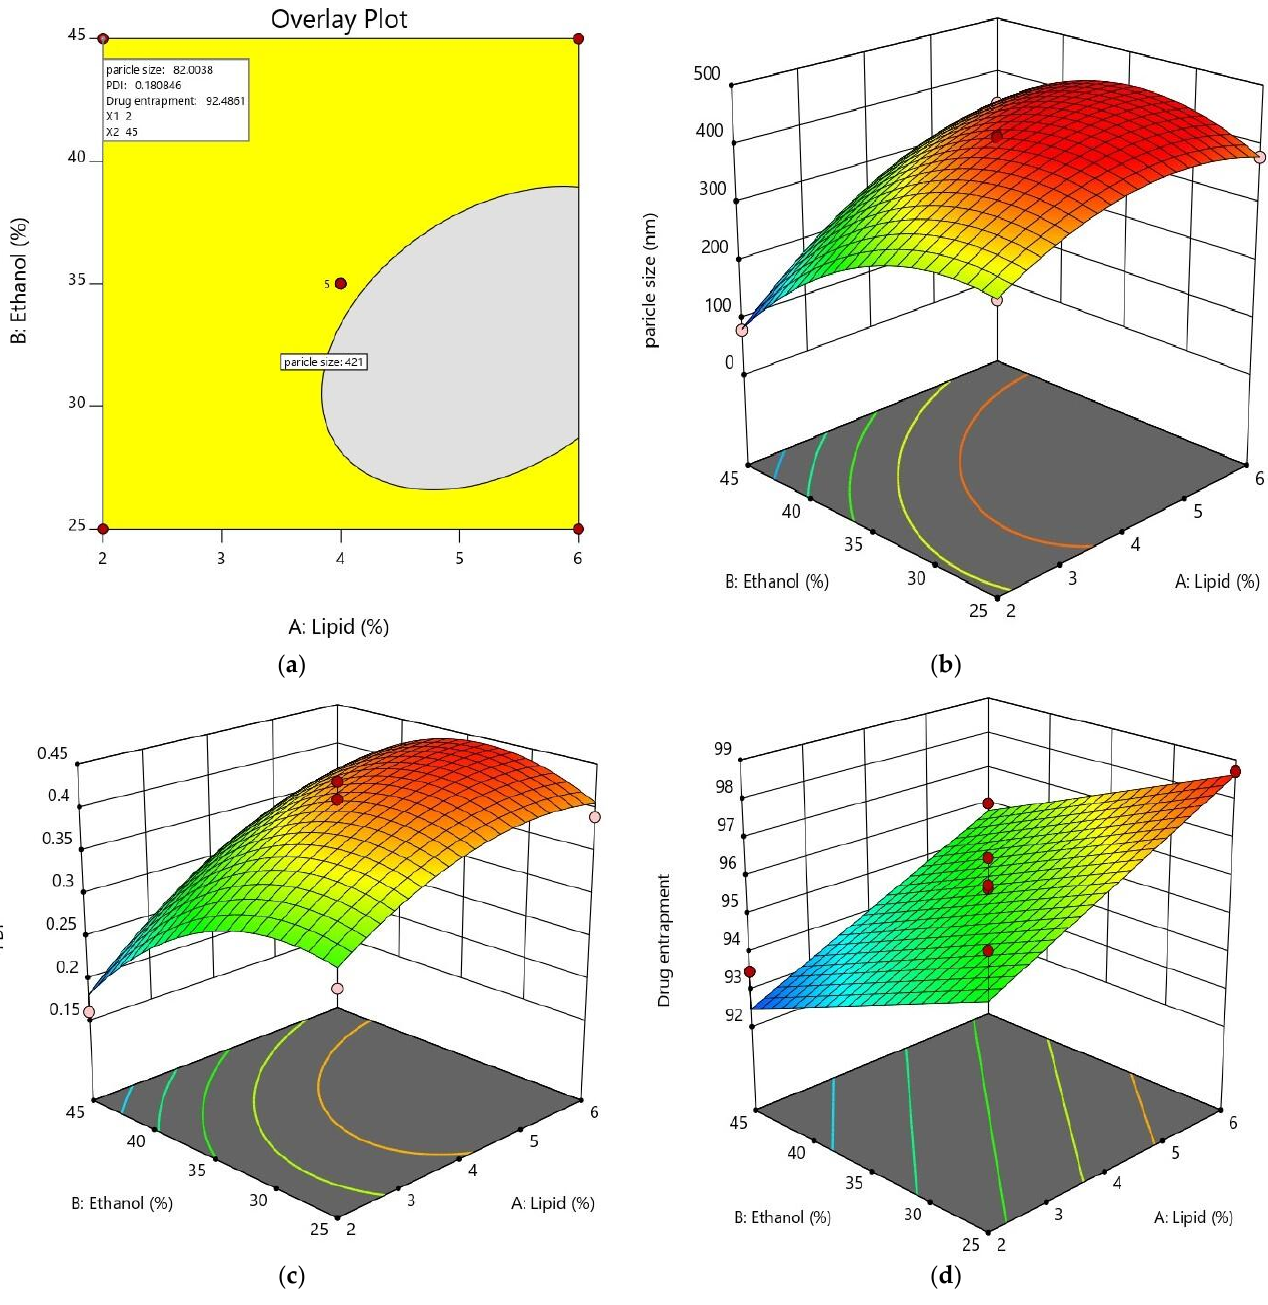
Figure 4. Overlay plot generated by Design of Expert depicting ( a ) a robust yellow region, ( b ) a 3D response surface graph depicting the effect of the independent variable on particle size, ( c ) effect of the independent variable on PDI and ( d ) effect of the independent variable on drug entrapment. Table 4. Lists of dependent variables and independent variables for the formulation. It also enlists Table 5. Depicts the critical quality attributes and reason for their criticality for the preparation of the range of formulation variables used for the optimization of the formulation. ethosomal